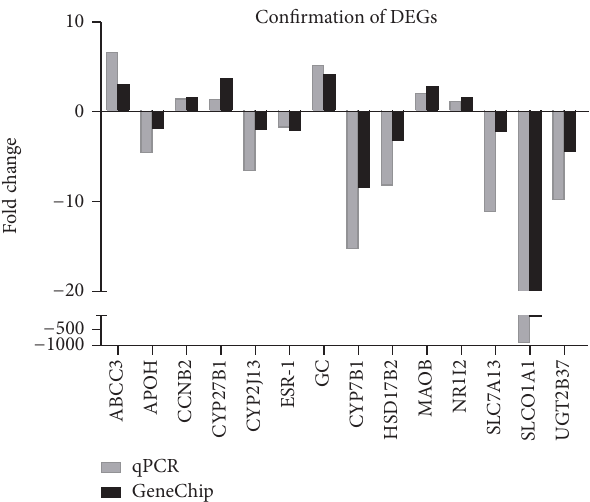
Figure 6: Confirmation of 14 representative DEGs by qPCR. The alterations in these genes at the mRNA level are similar between qPCR and